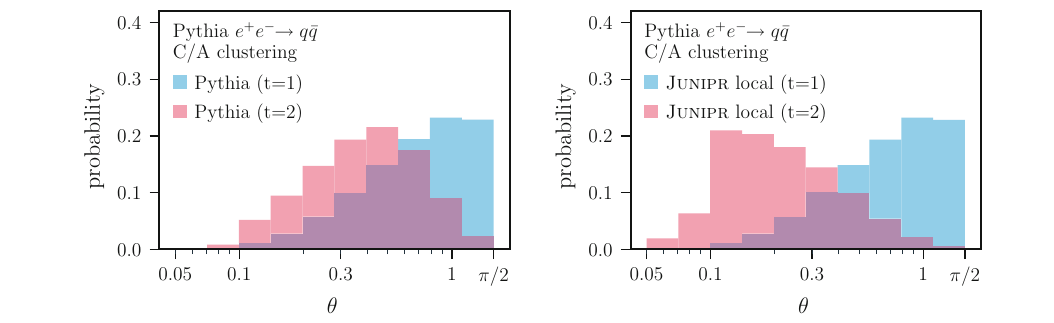
image (i.e. the cross sectional image perpendicular to the jet axis) from right-to-left and bottom-to-top, clustering parti- cles as it encounters them. Run in reverse (i.e. as a shower) particles are emitted from the jet core from left-to-right and top-to-bottom; this is how a jet image would be printed by an inkjet printer with a single printing tip. In Fig. 20 we show a single Pythia jet clustered using the printer algorithm. As can be seen in the jet image on the right side of Fig. 20, momenta are indeed emitted top-to-bottom. On the left side of Fig. 20, we see that any collinear branching structure is completely absent from the clustering tree; instead, particles are steadily emitted